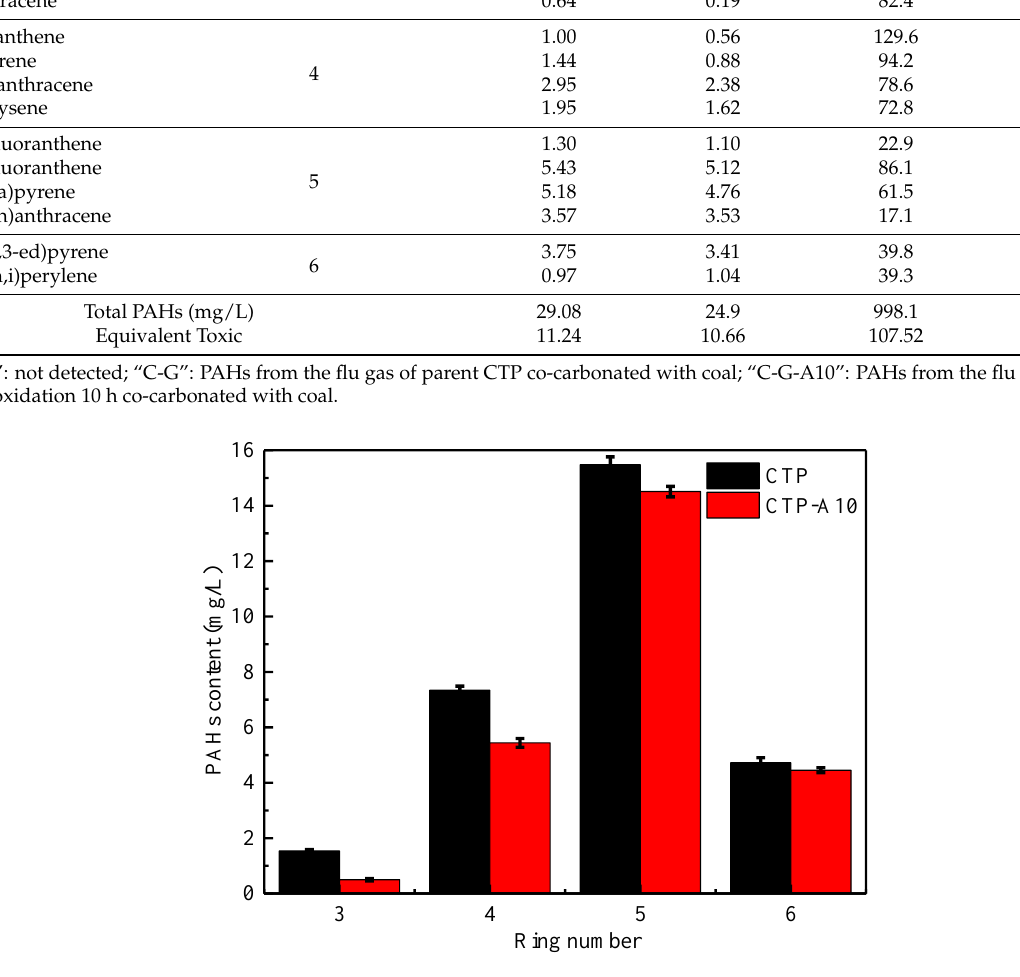
Figure 6. Soluble PAHs content of toluene in raw CTP and the catalytic air-oxidized CTP. Air-oxidized CTP.